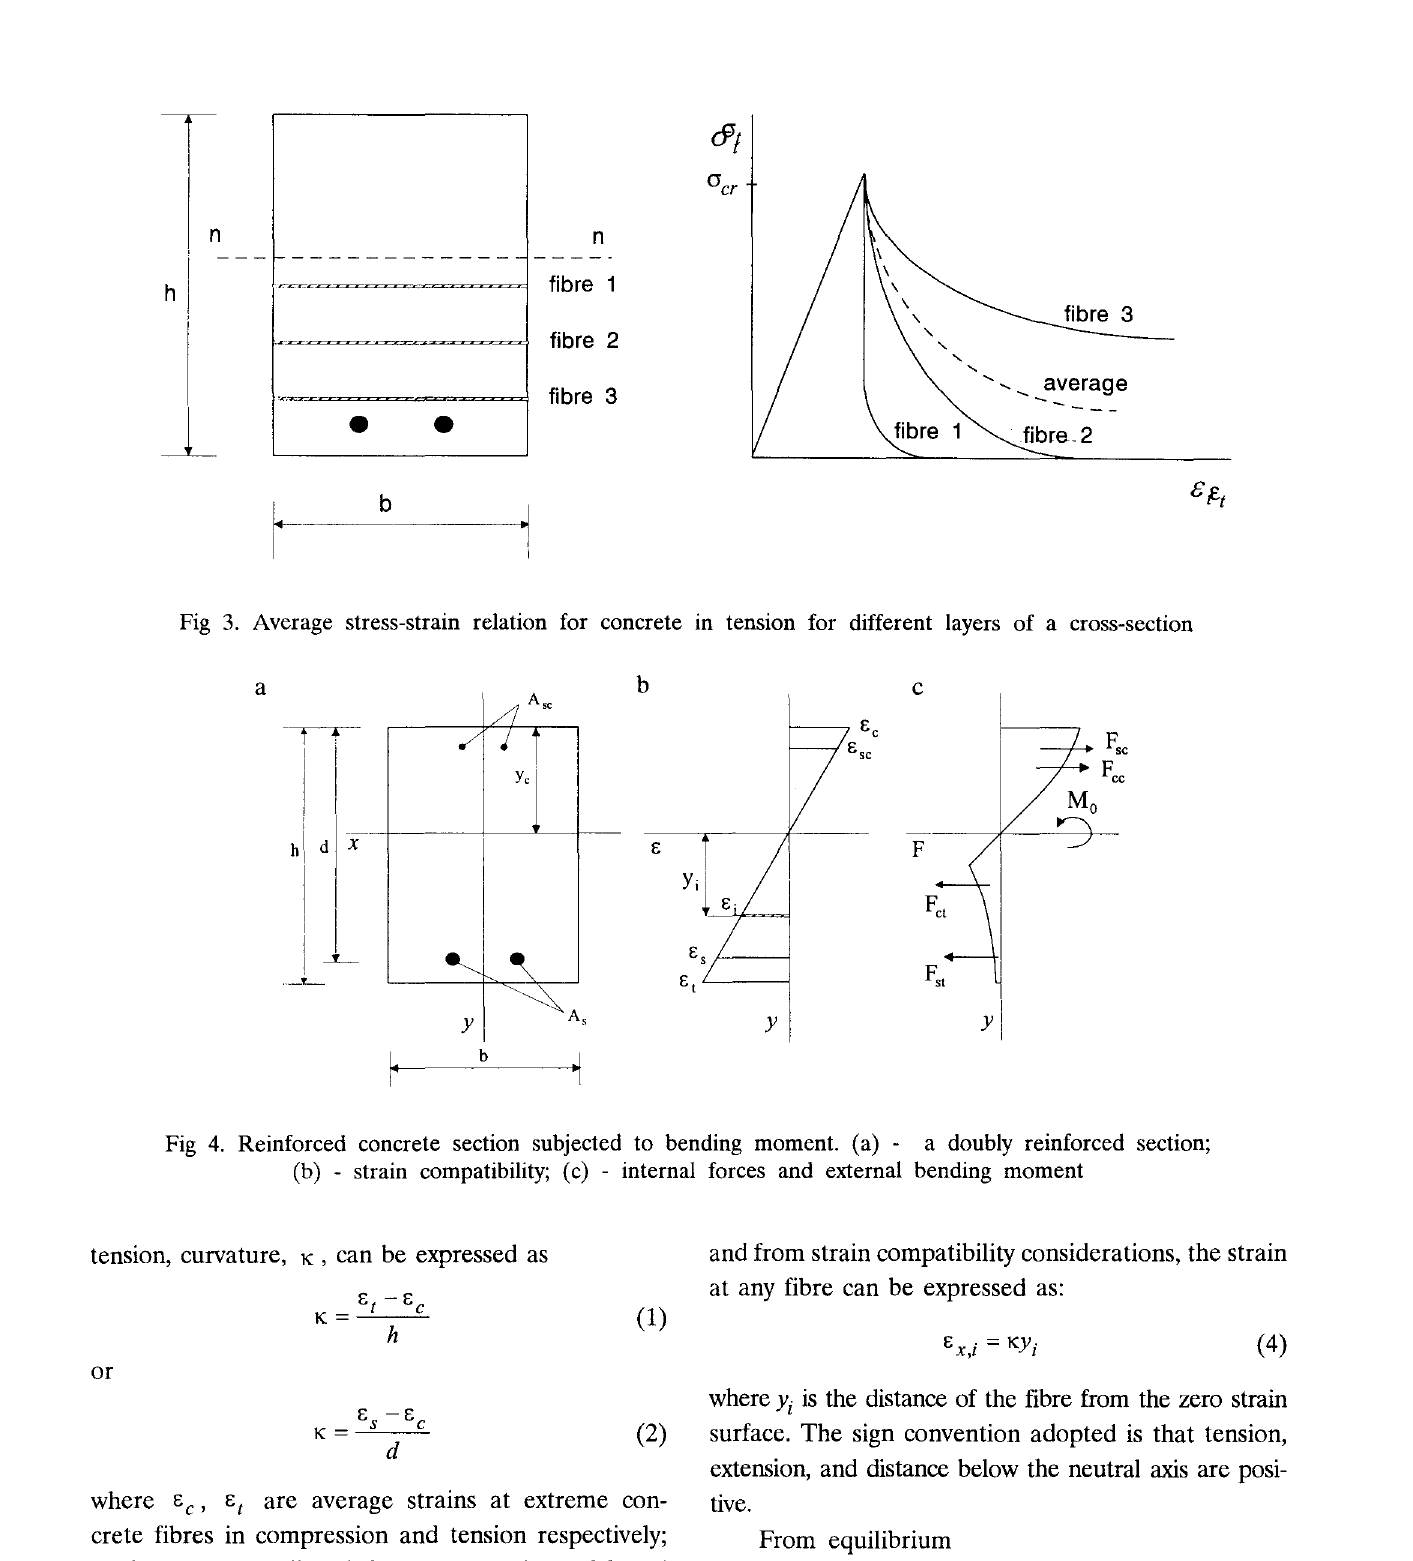
tension, curvature, K, can be expressed as or